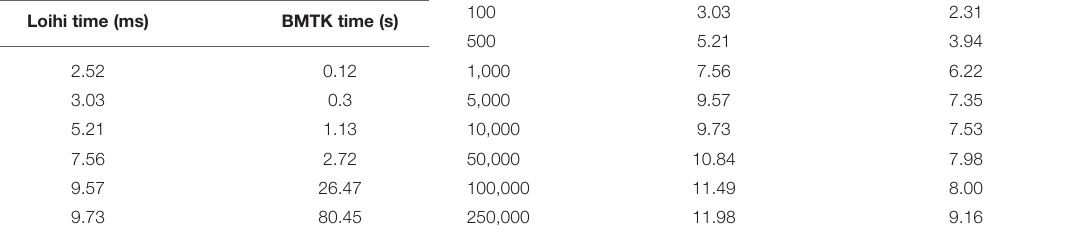
FIGURE 12 | Performance comparison between BMTK and Loihi for network sizes ranging from 1 to 20,000 for the simulation of 500 ms of dynamics. The values for each curve are scaled by the respective smallest runtime. The Loihi runtime units are in “ milliseconds ” and BMTK runtime is in “ seconds ”. TABLE 5 | Simulation runtime in Loihi and BMTK.